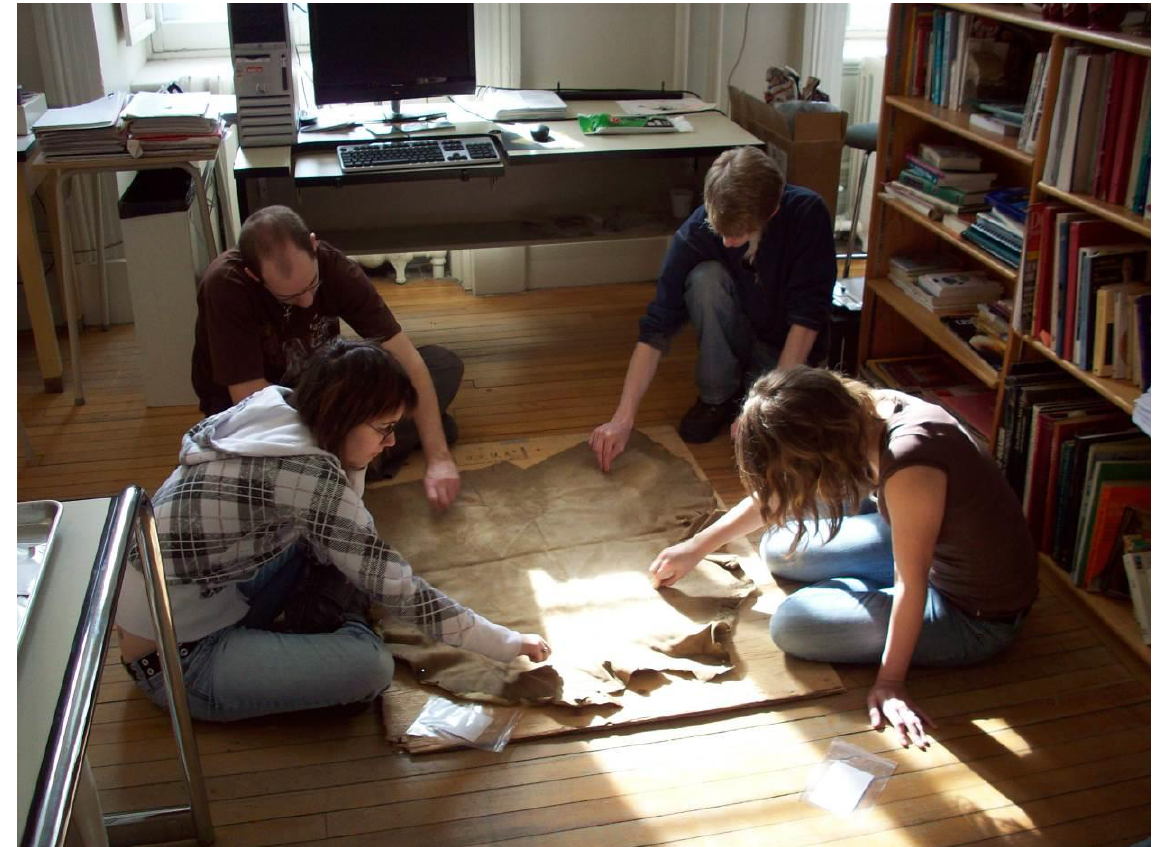
Figure 3: Experimenters scraping the dry ungulate